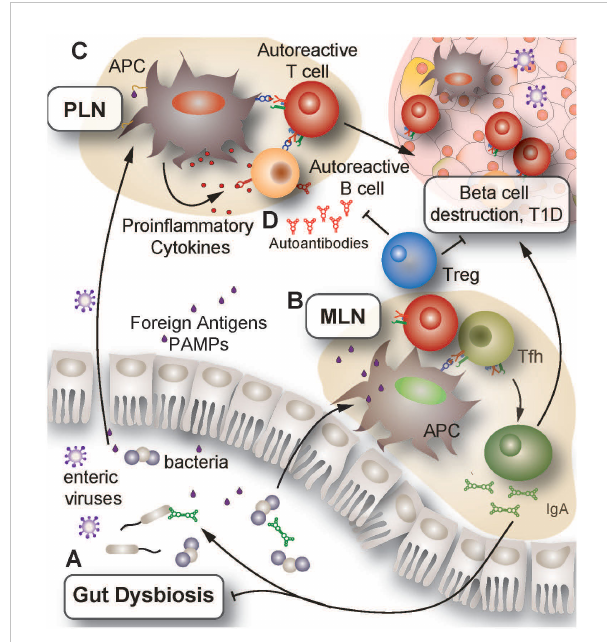
FIGURE 1 Proposed mechanisms of autoimmune activation leading to